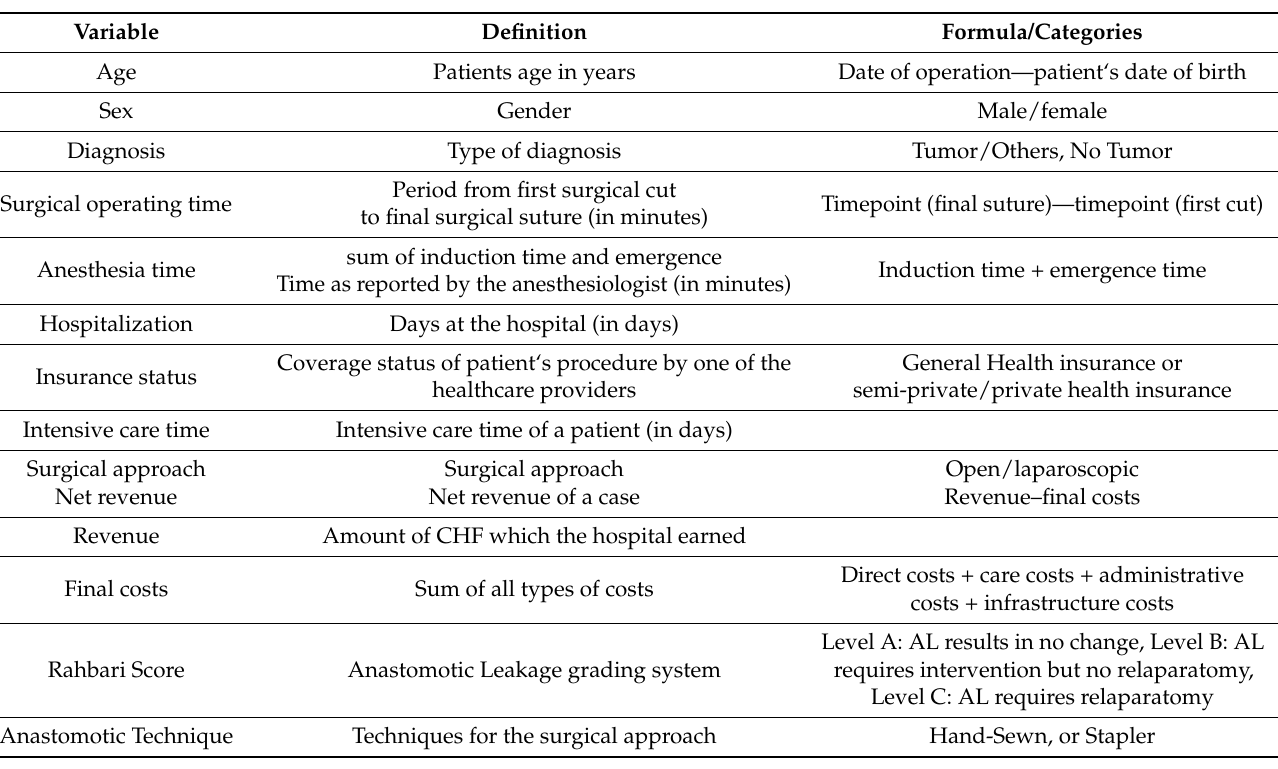
Table 1. Variables used for statistical testing with their definition and a formula for the parameters.